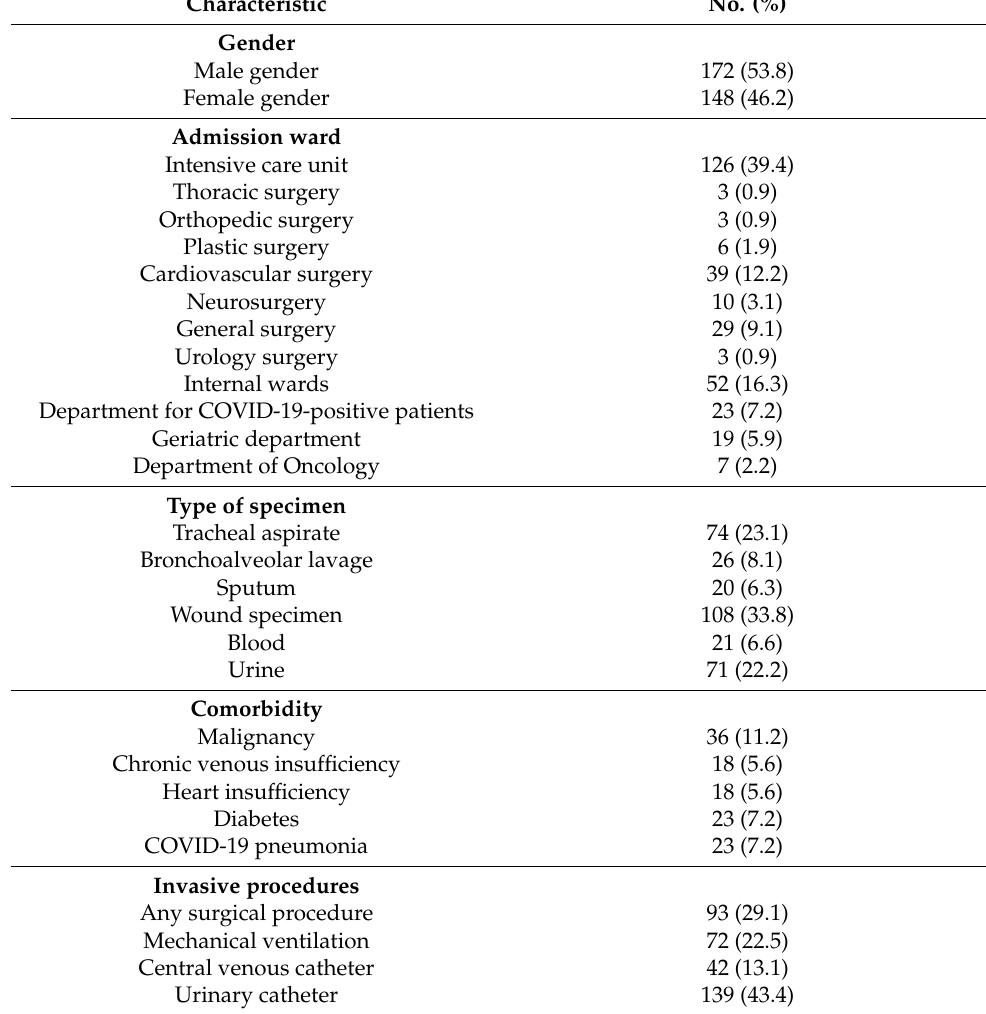
Table 1. Demographic and clinical characteristics of Pseudomonas aeruginosa -infected study